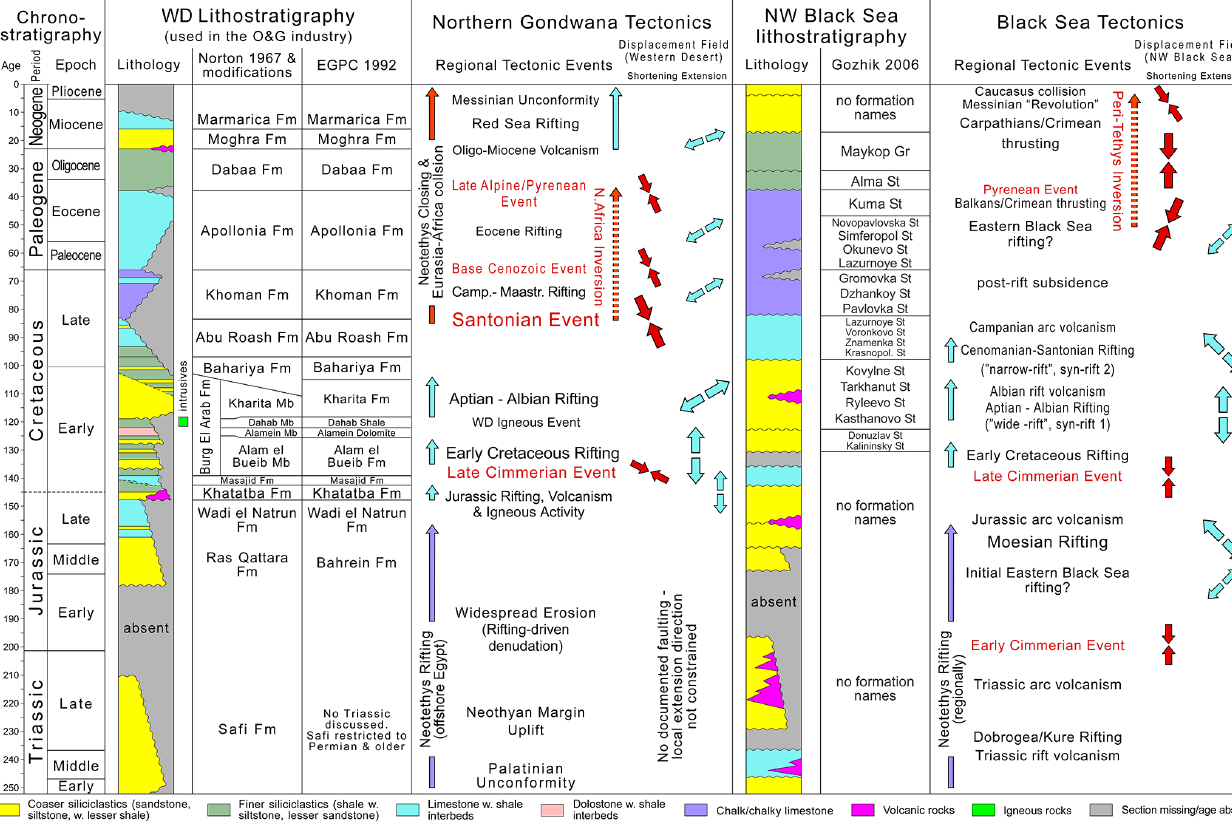
Figure 3. Mesozoic to Cenozoic tectonostratigraphy of the Western Desert and Black Sea regions. Extensional and shortening events are separated for clarity. In some basins both extensional and contractional inversion structures are observed to have developed simultaneously. Timescale is from Ogg et al. (2016). Gr: group; Fm: formation; Mb: member; St: